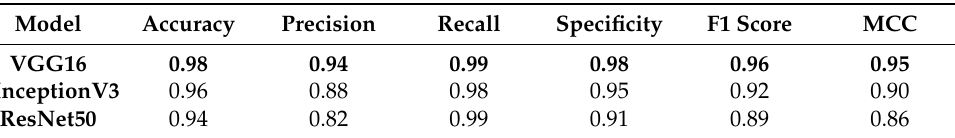
Table 2. An overview of evaluation metric results was obtained for VGG16, InceptionV3, and ResNet50 using the fine-tuning approach. Model Accuracy Precision Recall Specificity F1 Score MCC